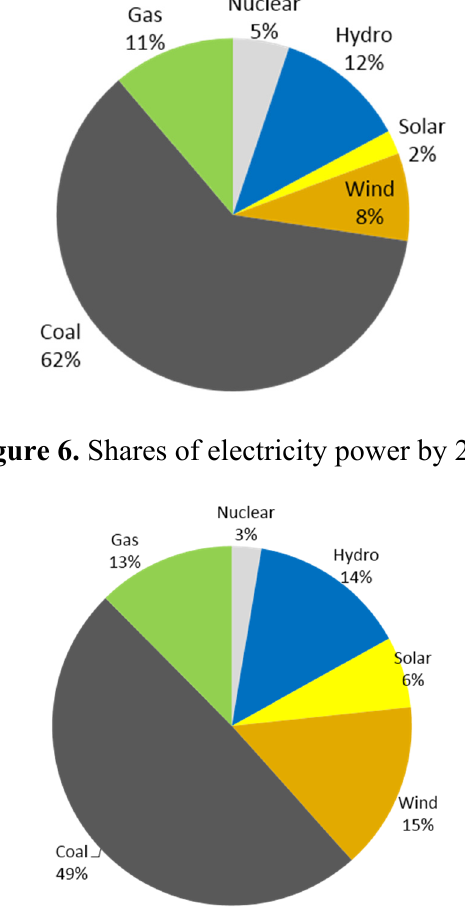
Figure 7. Shares of installed capacity by